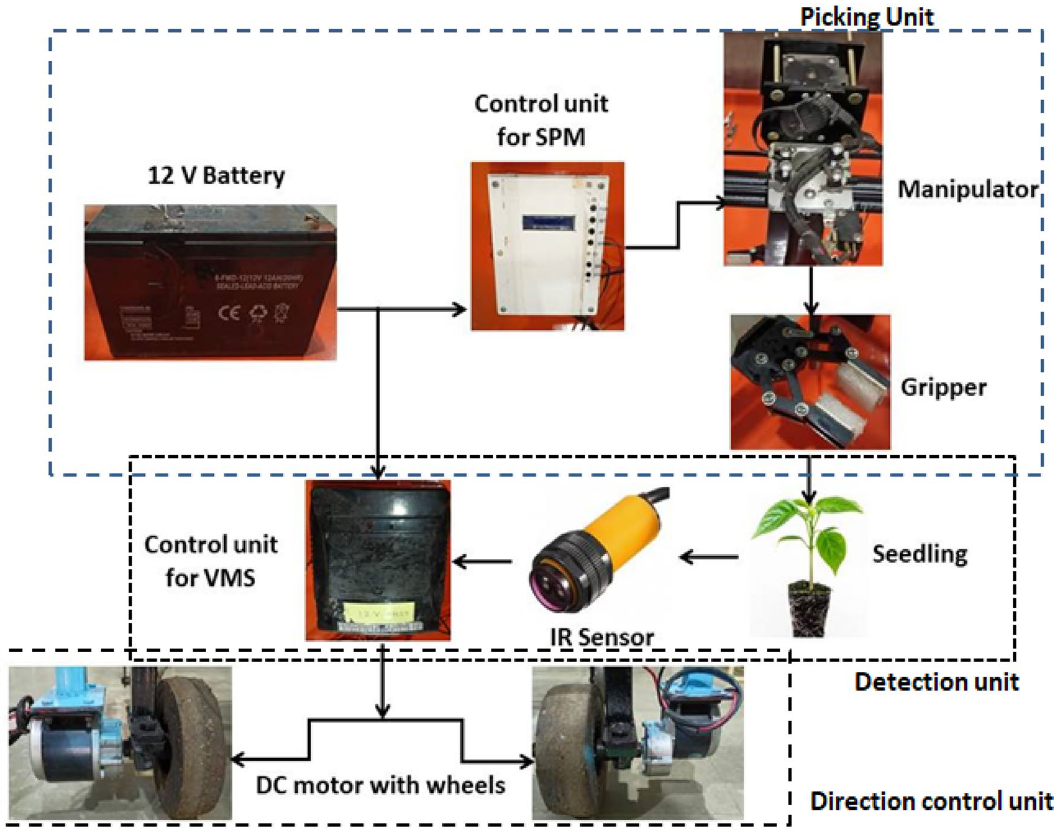
Figure 2. Working principle of the robotic transplanter ( a ) picking unit; ( b ) detection unit; ( c ) direction control